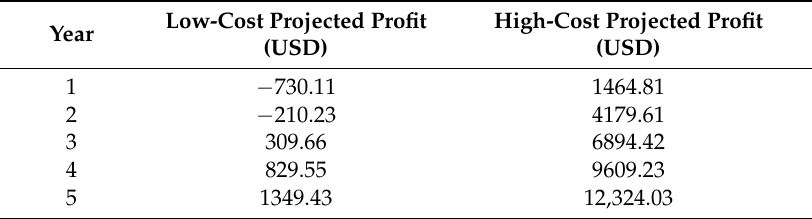
Table 3. The profit to the user was projected when printed items, produced at a rate of one per week, were compared to low and high cost comparable, commercially available products.